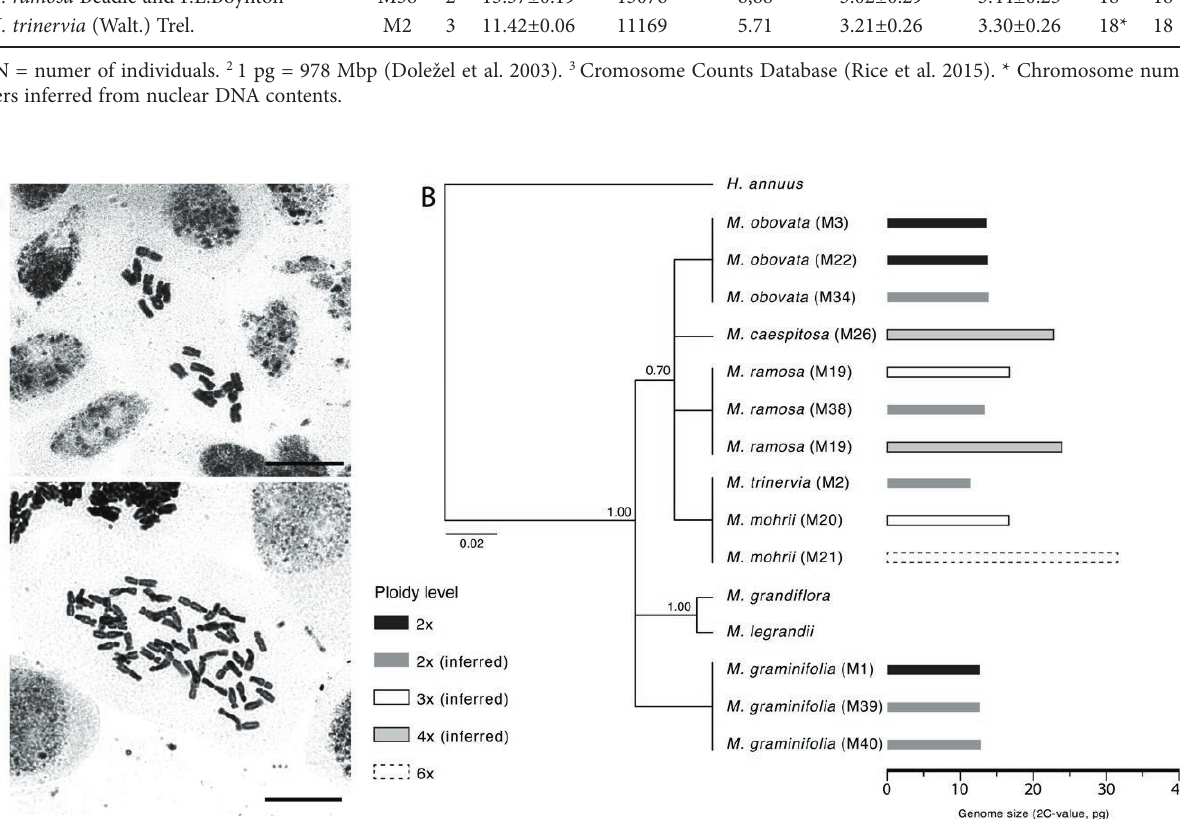
Figure 1. A. Illustrative chromosome counts in Marshallia : (top) Marshallia obovata (Walt.) Baedle and F.E. Boynton (M3, 2n = 18). (bot- tom) Marshallia mohrii (M21, 2n = 56). Scale bars are 10 μm. B. Phylogenetic mapping of genome size data (2C-values) based on ITS sequences from Hansen and Goertzen (2014). Inferred ploidy levels based on nuclear DNA contents are